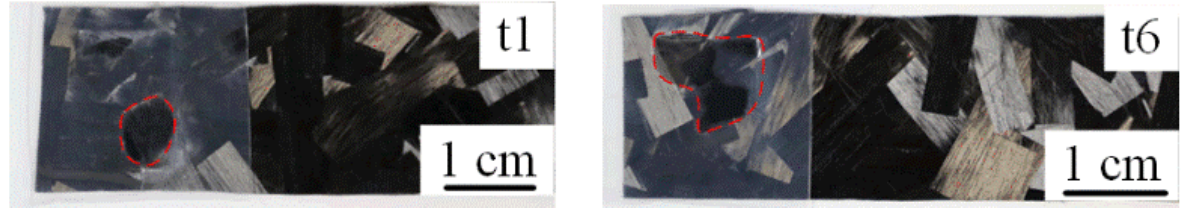
Figure 17. Joining process window of the SPCC-CFRTP hybrid joint by the UPW.